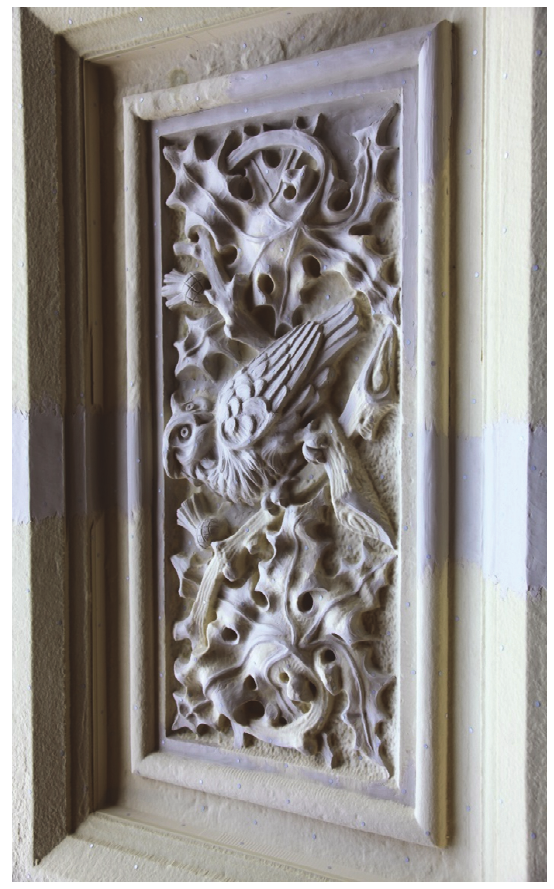
Figure 7. CNC-milled polyurethane foam maquette of relief sculpture with modelling clay applied